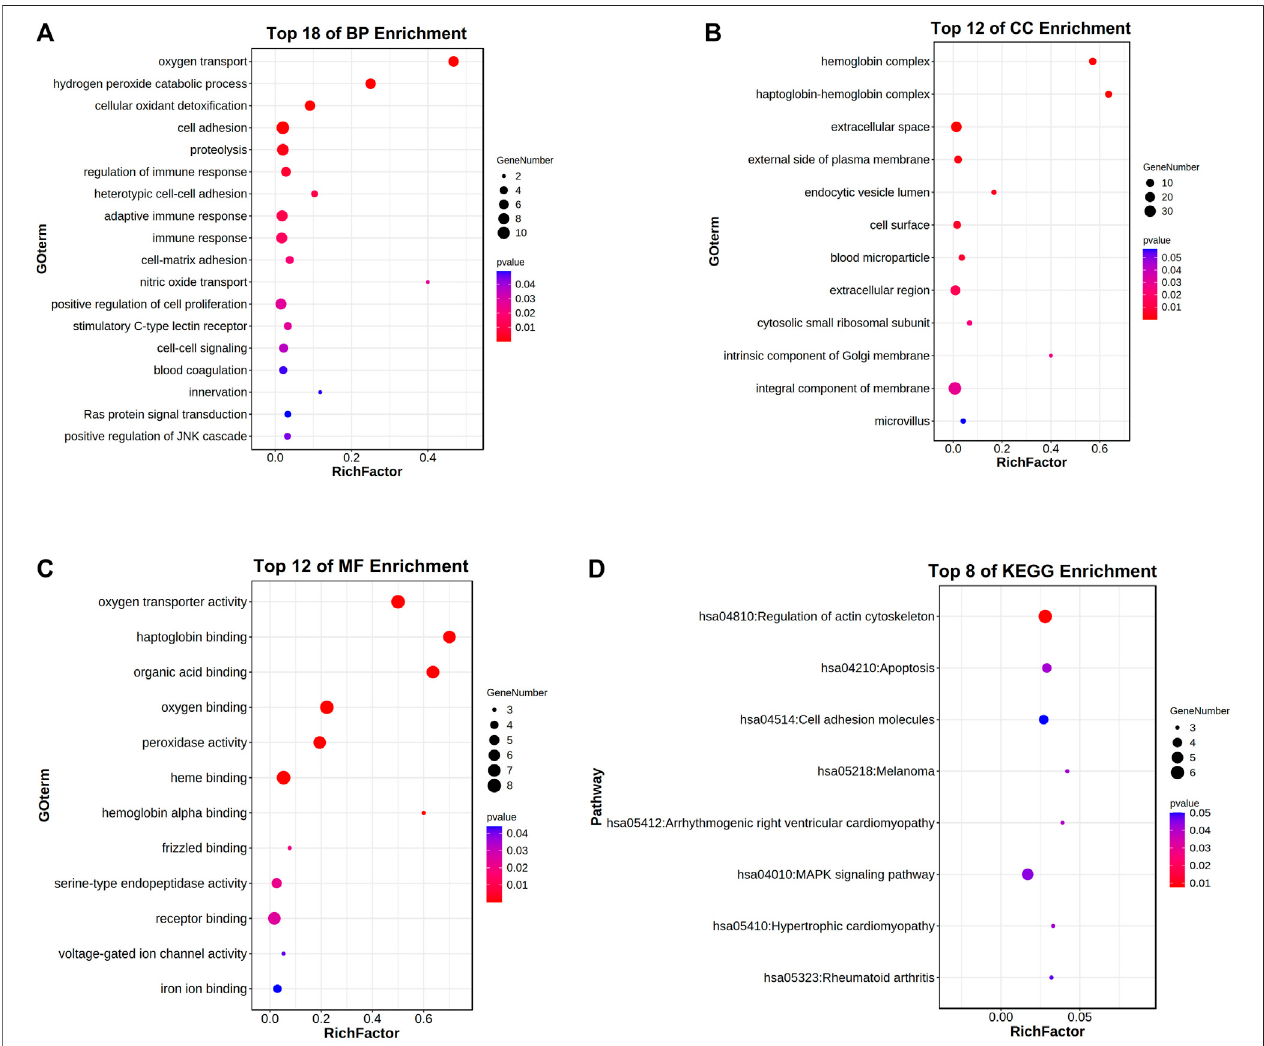
FIGURE11| EnrichmentanalysisfortherelativegenesofHBG1andHBDviatheDAVID. (A) Intheaspectofthebiologicalprocess(BP),therelativegenesofHBG1 and HBD were mainly enriched in blood coagulation and in the regulation of immune response. (B) In the aspect of the cellular component (CC), the relative genes of HBG1 and HBD were mainly enriched in the blood microparticle, extracellular region, haptoglobin – hemoglobin complex, and hemoglobin complex. (C) In the aspect of cellular molecular function (MF), the relative genes of HBG1 and HBD were mainly enriched in the hemoglobin alpha binding, oxygen binding, oxygen transporter activity, and haptoglobin binding. (D) In the aspect of KEGG, the relative genes of HBG1 and HBD were mainly enriched in apoptosis, cell adhesion molecules, and regulation of actin cytoskeleton.